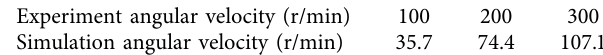
Table 3: Experiment and simulation parameters (angular velocity).